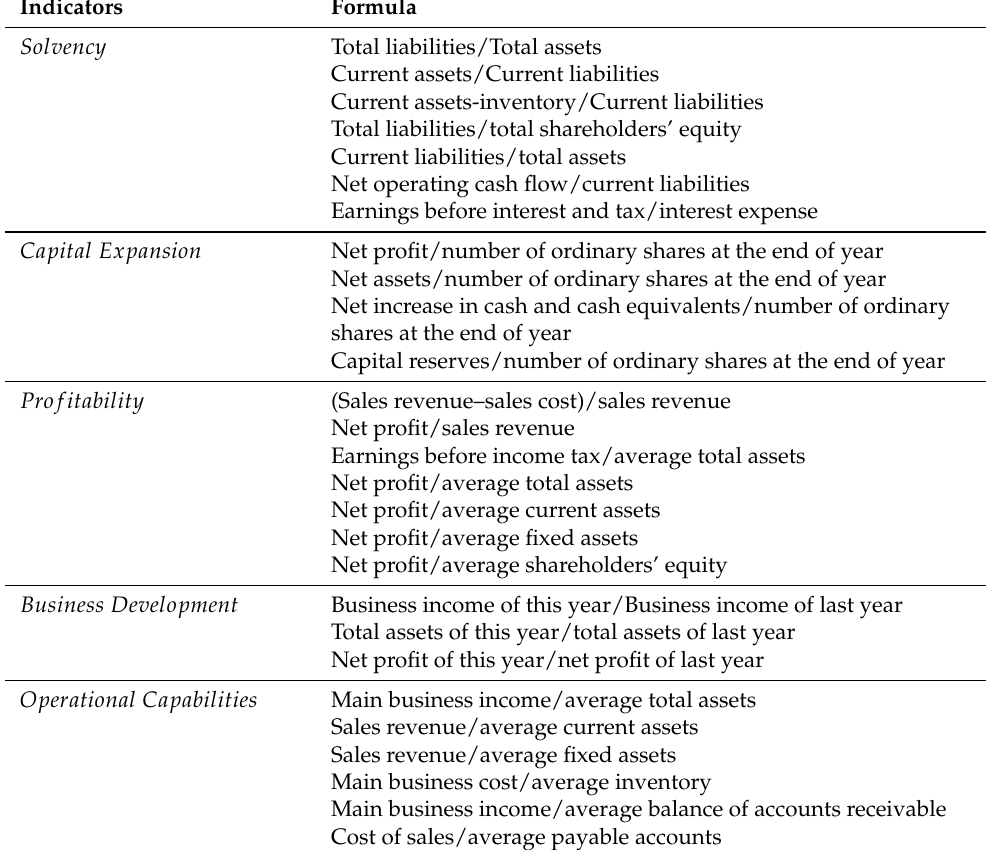
Table 1. Financial